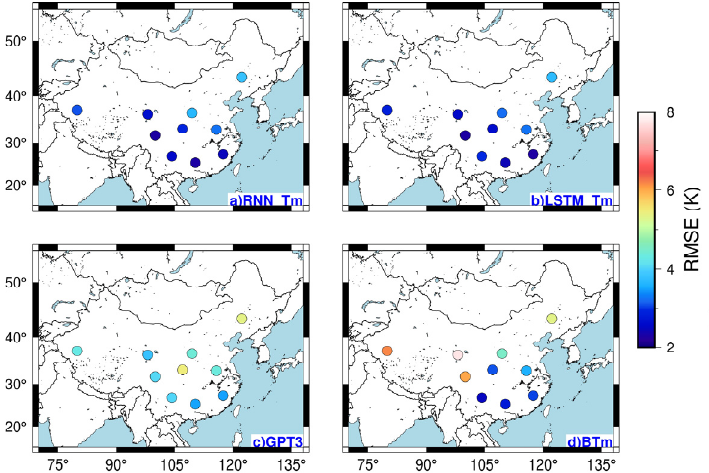
Figure 10. Distribution of the RMSEs of the four models at 10 non ‐ modeling stations. ( a ) RNN_Tm, ( b ) LSTM_Tm, ( c ) GPT3, and ( d ) BTm models. ( b ) LSTM_Tm, ( c ) GPT3, and ( d ) BTm